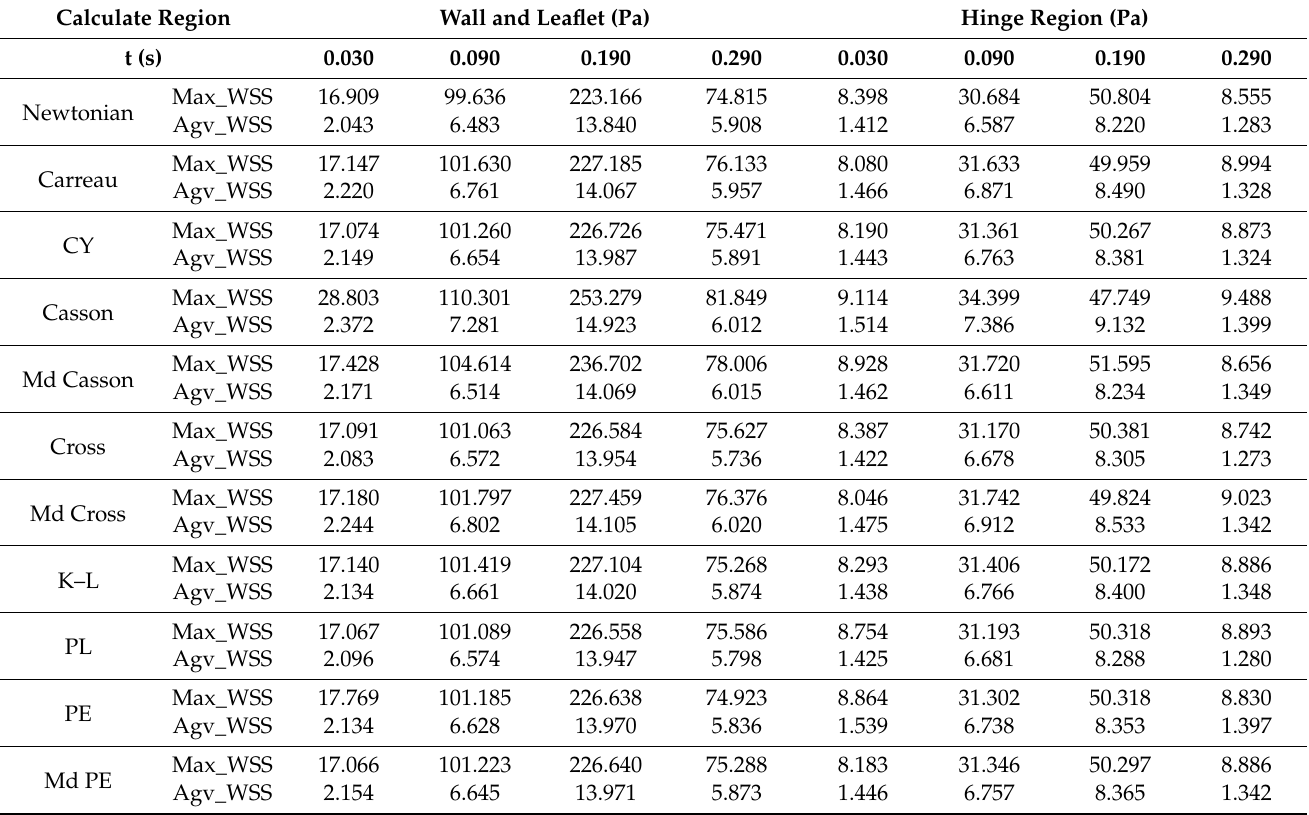
Table 3. Maximum and average values of the WSS in an